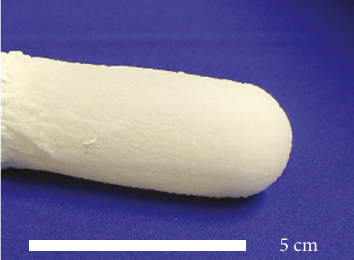
– polymer nanocomposite 3